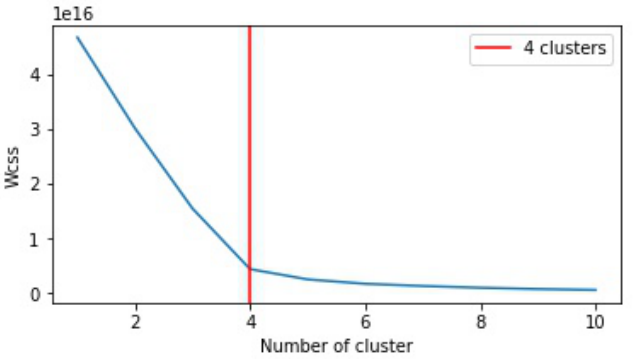
Figure 6. Elbow curve graph. The blue line indicate the within-cluster sums of squares values. The more this value decreases, the greater the number of clusters. The red line indicates the exact point where the "elbow" occurs, which indicates the optimal number of clusters to choose from, in our case